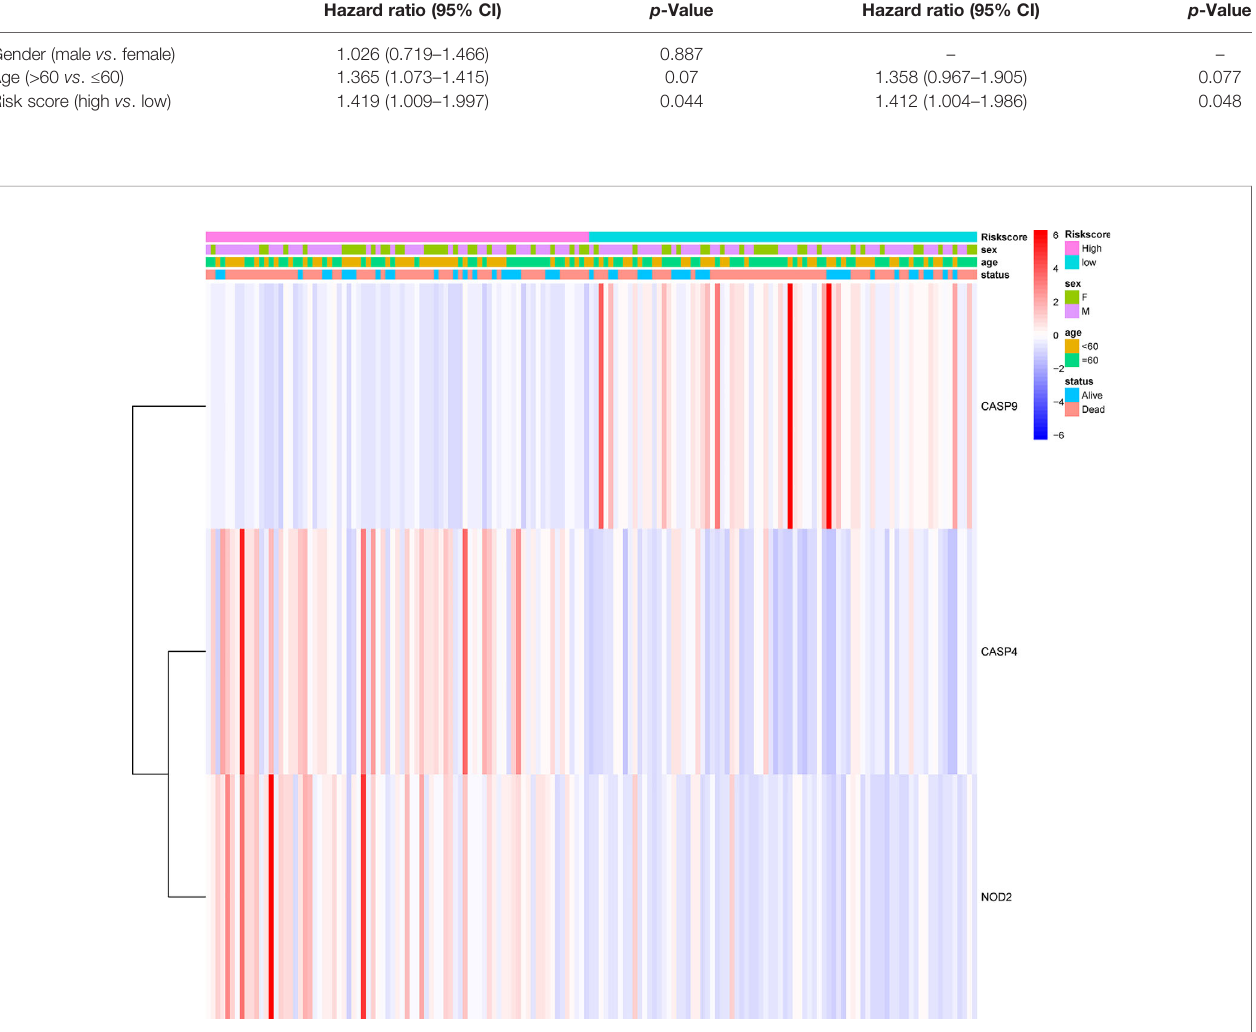
FIGURE 5 | Heatmap (blue: low expression; red: high expression) for the connections between clinicopathological features and the risk